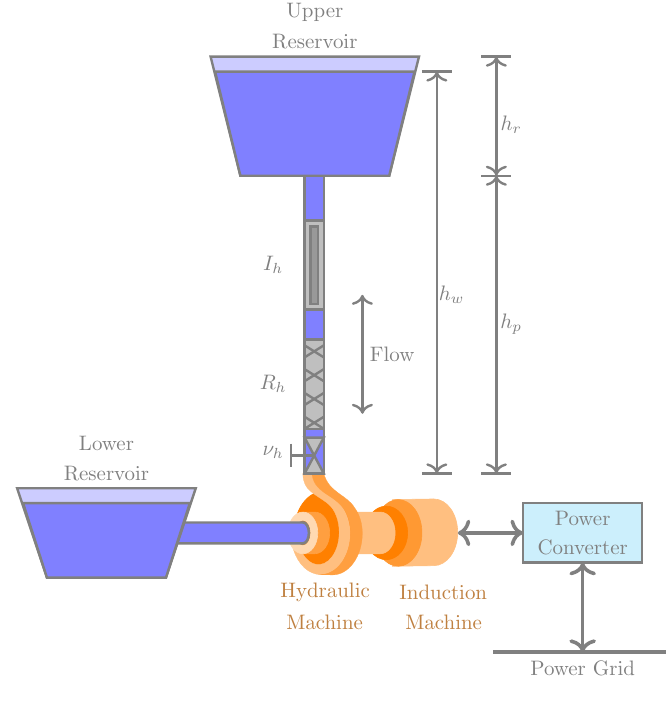
Figure 1. General diagram of reversible hydropump–turbine